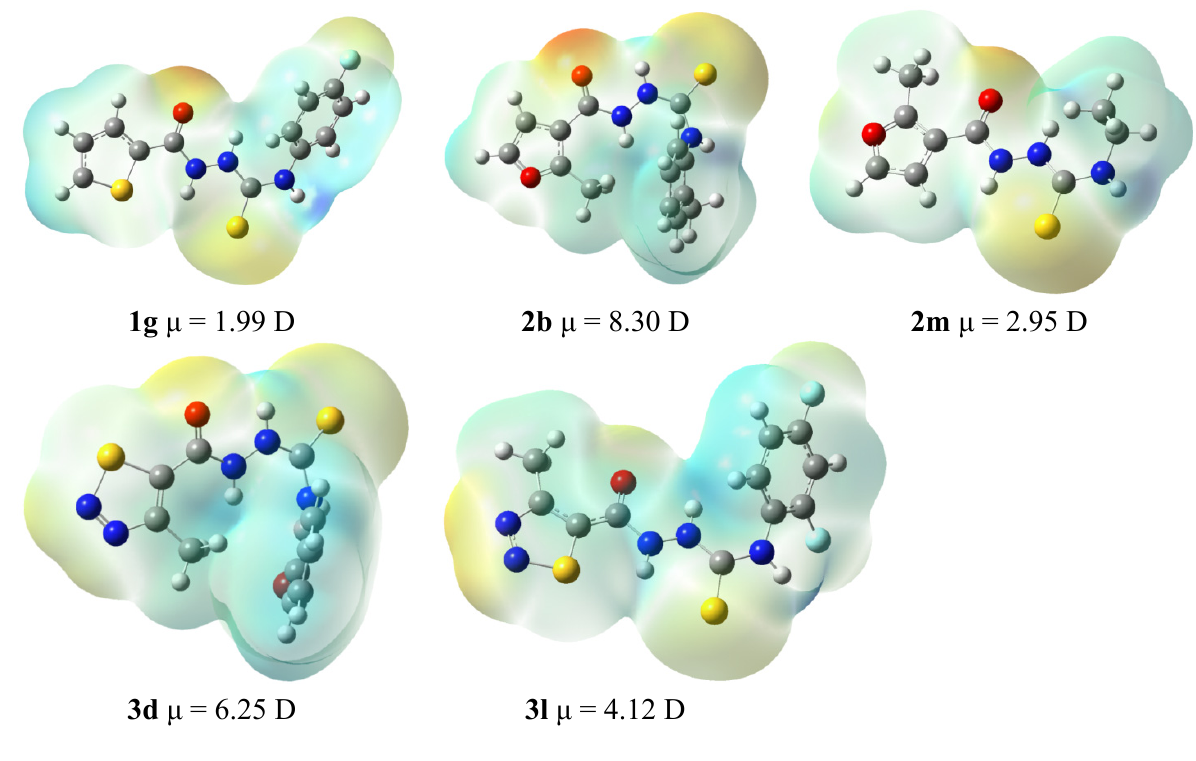
Figure 3. The electrostatic potential surfaces and dipole moments of 1g , 2b , 2m , 3d , and 3l